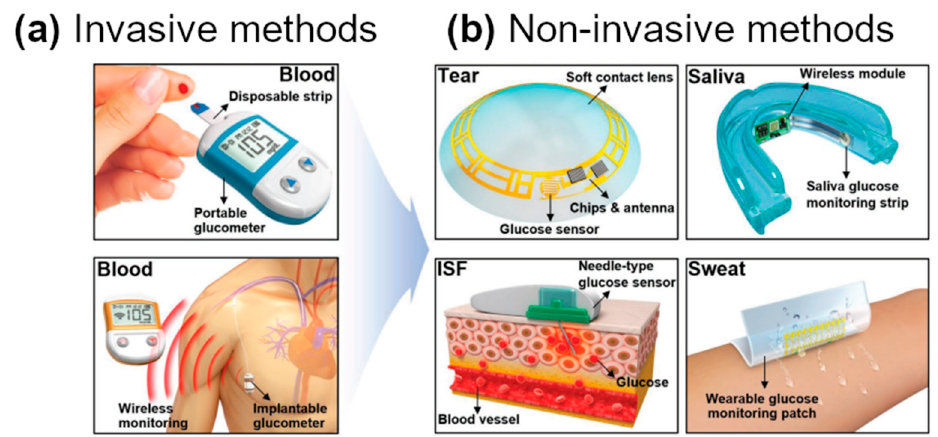
Figure 7. Evolution of glucose sensors using ( a ) invasive and ( b ) non-invasive methods. Modified and reproduced with permission from [137], Copyright Wiley-VCH (2018).